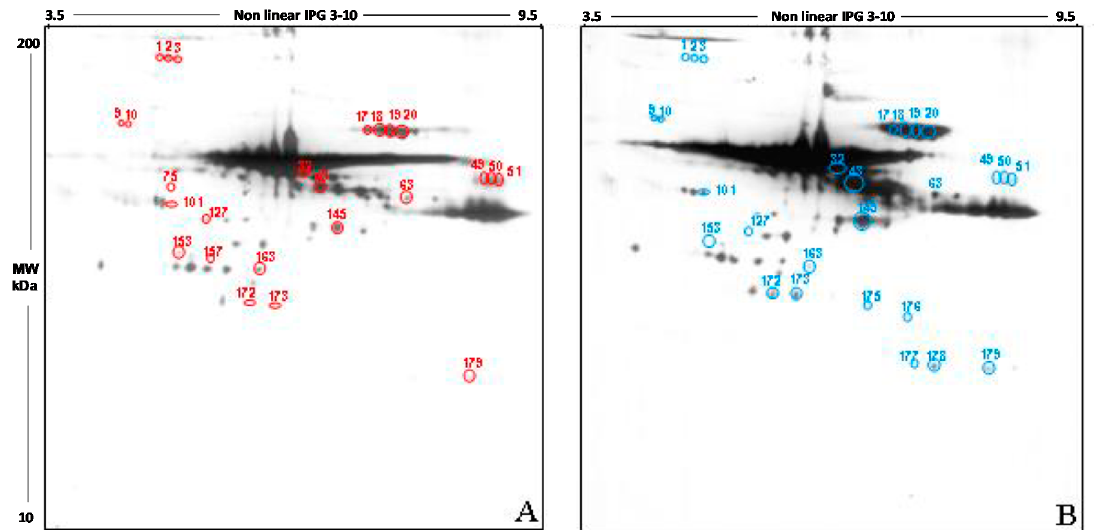
Figure 4. Western blotting after two dimensional electrophoresis showing carbonyl group in follicular fluid from young ( A ) and old ( B ) women. 2D electrophoresis was independently carried out in pooled samples in triplicate for each group, giving similar results.